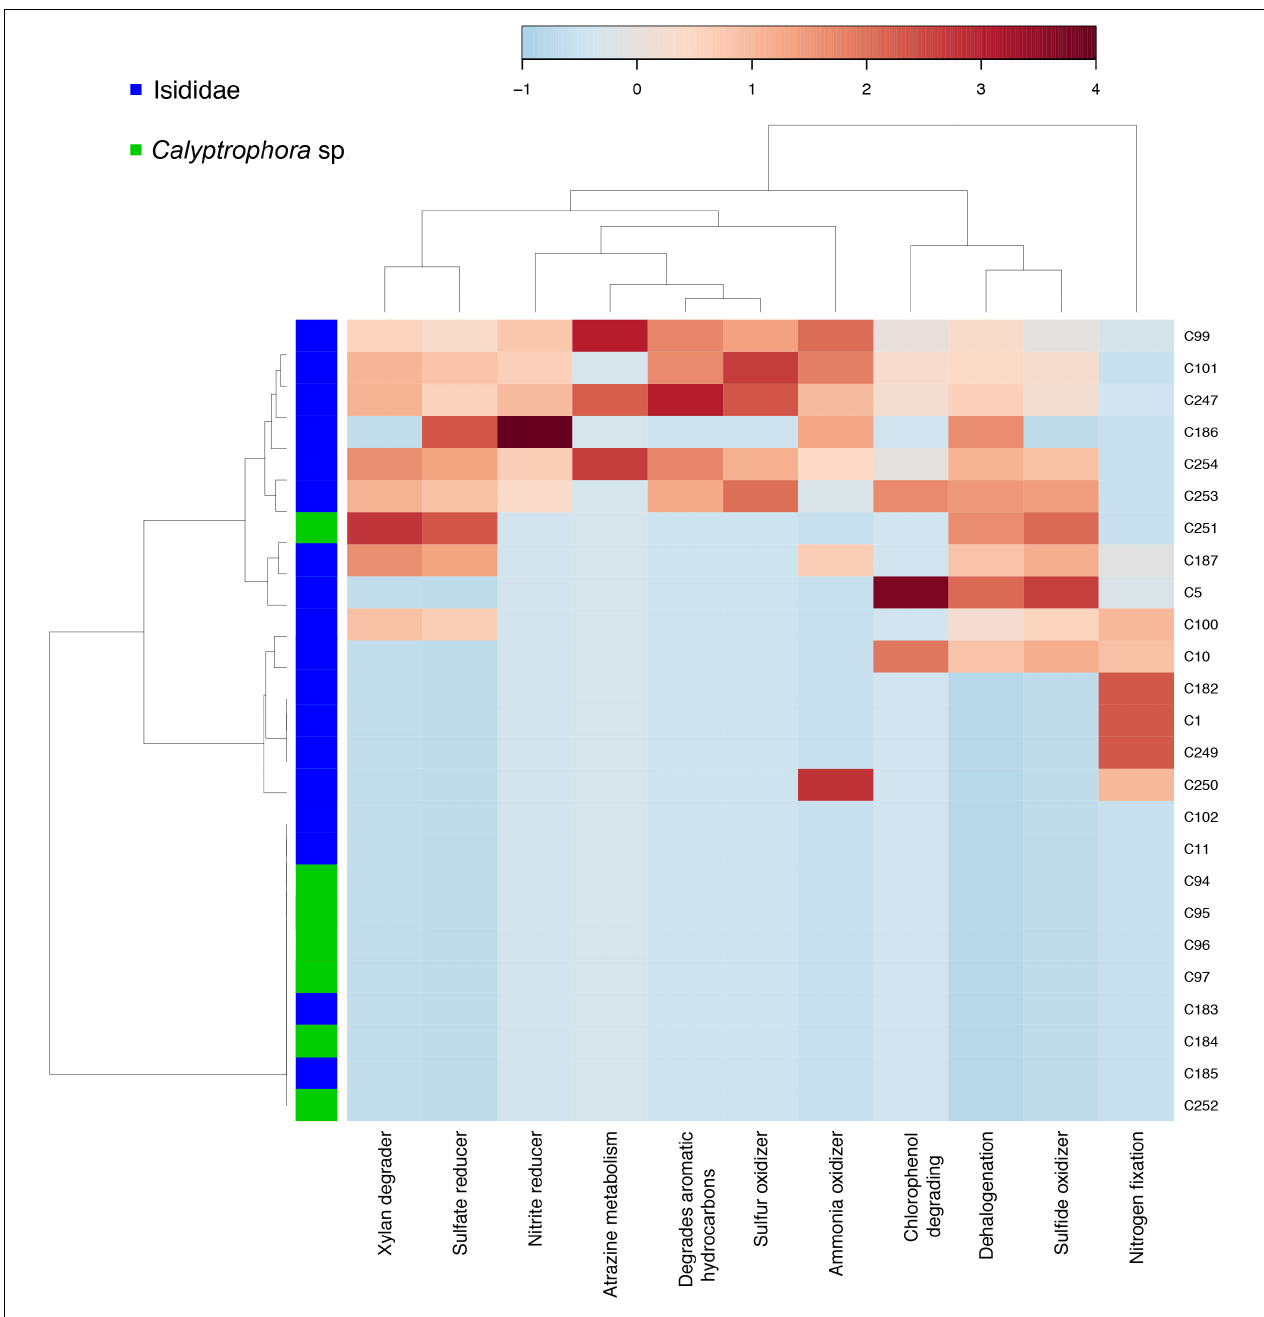
FIGURE 4 | Taxonomy-based functional profiling of bacterial communities in coral samples from Isididae and Primnoidae families. Shifts in potential functional differences are represented by a relative abundance scale showing the enrichment (red color) and depletion (blue color) in different metabolic profiles mapped to the corresponding taxonomic information. Hierarchical clustering of samples and functions was performed by a single linkage algorithm using Euclidean distance